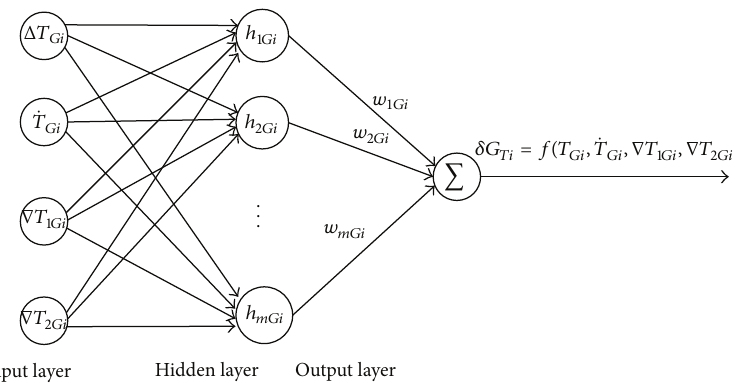
Figure 2: Temperature error modeling for gyroscope assembly based on RBF neural